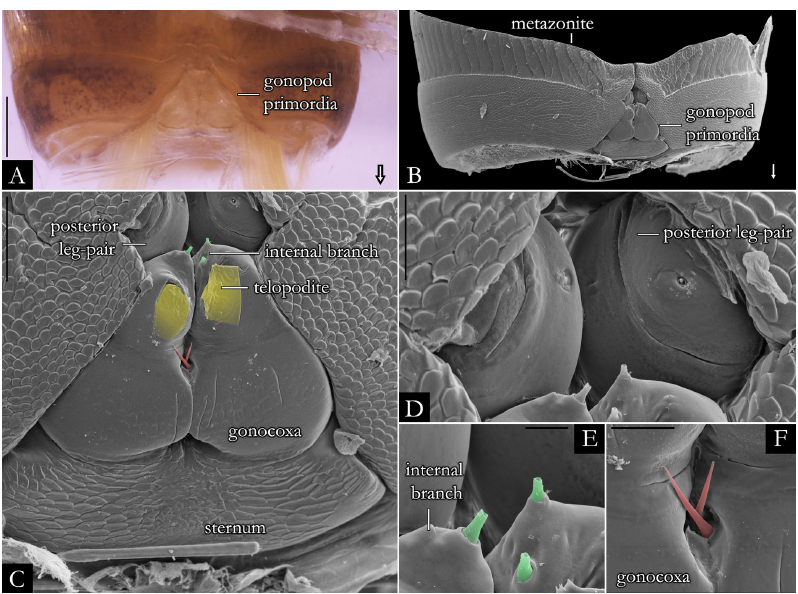
Fig. 33. Ontogeny of the gonopods in Pseudonannolene microzoporus Mauriès, 1987 (IBSP). A–B . Seventh body ring with the gonopod primordia in early stadium, ventral view. C . Gonopod primordia in intermediate stadium, ventral view. Telopodite highlighted in yellow. D . Detail of posterior leg-pair modified. E . Setae (highlighted in green) on internal branch of the gonopod primordia. F . Macroseta (highlighted in red) on gonocoxa of the gonopod primordia. Scale bars: A–B = 0.5 mm; C = 0.2 mm; D = 0.04 mm; E = 0.01 mm; F = 0.02 mm.